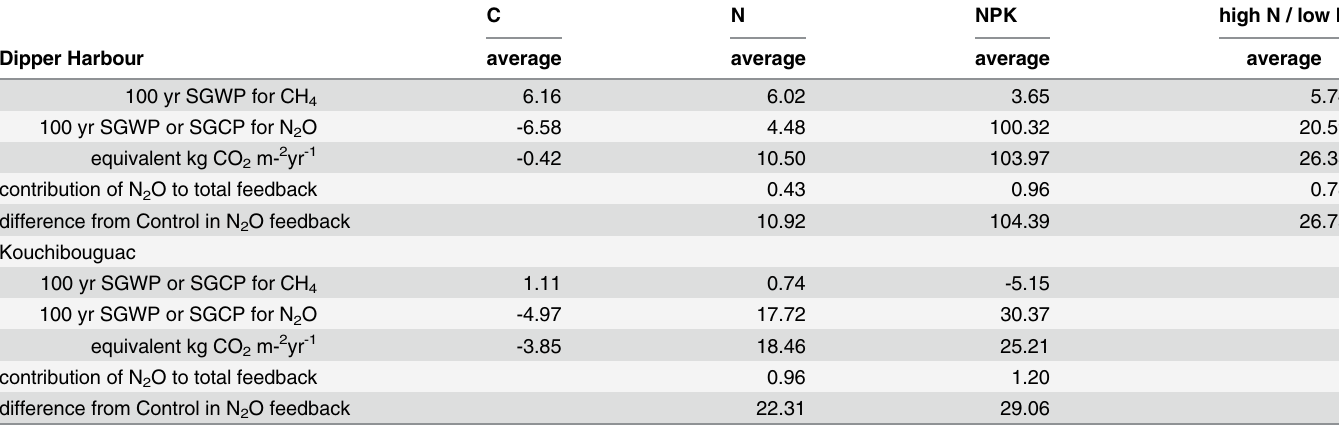
Table 6. Sustained flux global climate change potential for greenhouse gas fluxes of a micro-tidal and macro-tidal salt marsh with varied chronic fertilization